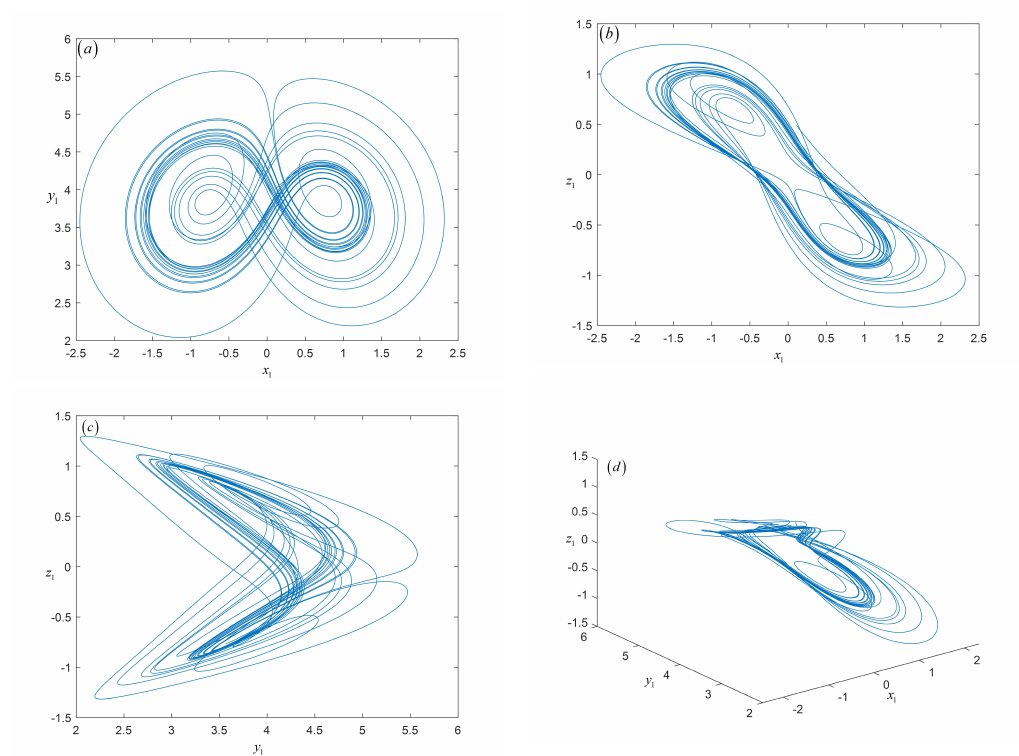
Figure 2. Phase–space trajectory distribution of fractional delay Liu system: ( a ) X–Y plane; ( b ) X–Z plane; ( c ) Y–Z plane; ( d ) X–Y–Z